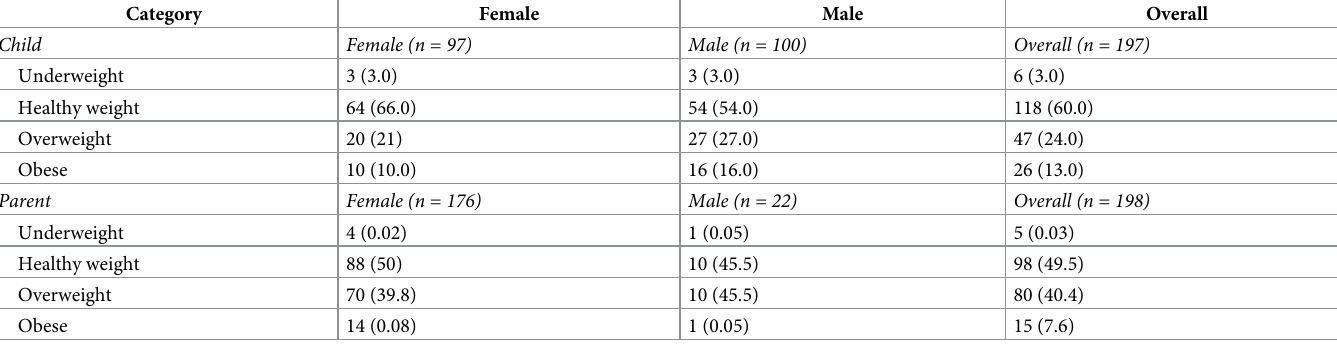
Table 2. Actual parent and child weight frequencies and percentages by weight category and by